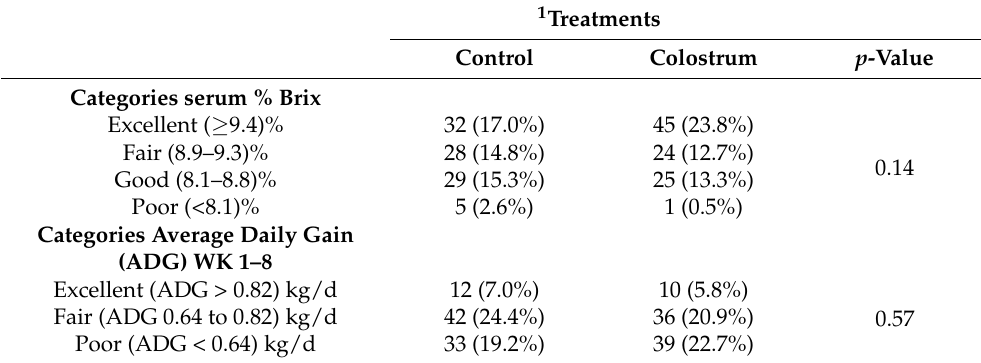
Table 2. Overall average daily gain (ADG) wk 1–8 and serum % Brix categories by treatment.